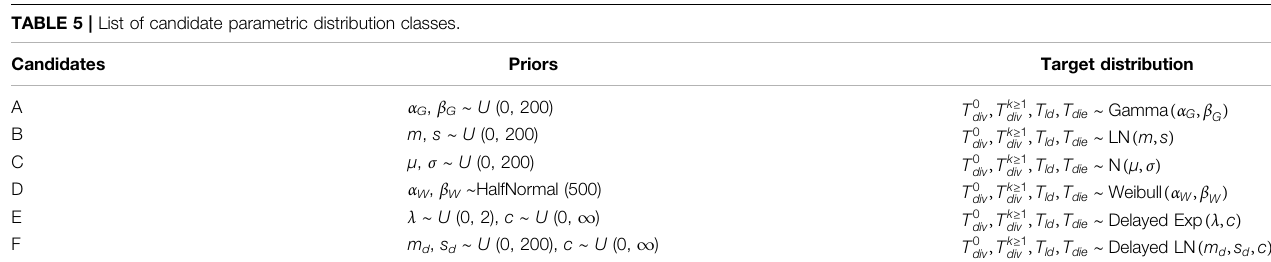
TABLE 5 | List of candidate parametric distribution classes. Candidates Priors Target